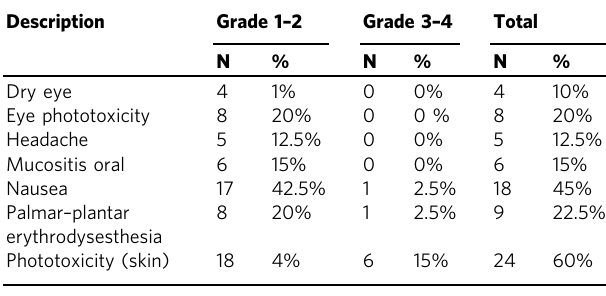
Table 5 Treatment-related non-hematologic adverse events were reported in ≥ 10% of patients treated with CX-5461 in the